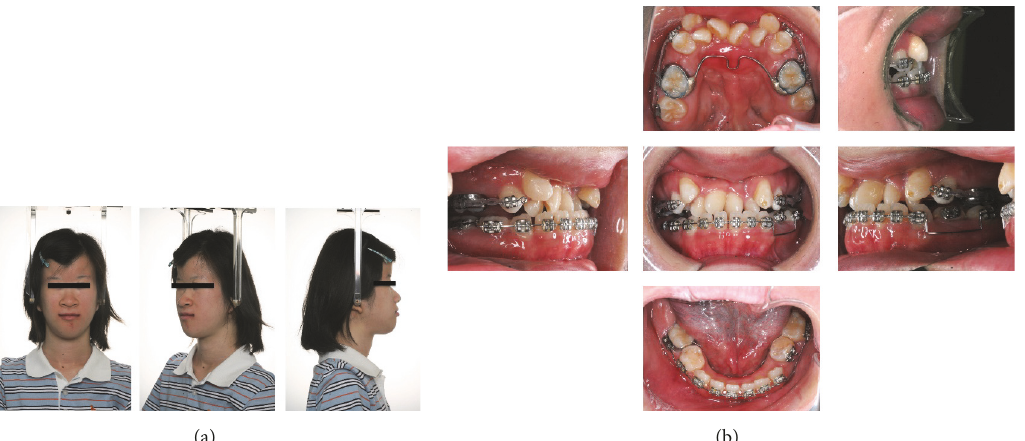
Figure 7: Facial (a) and oral (b) photographs after the consolidation period (19 years).